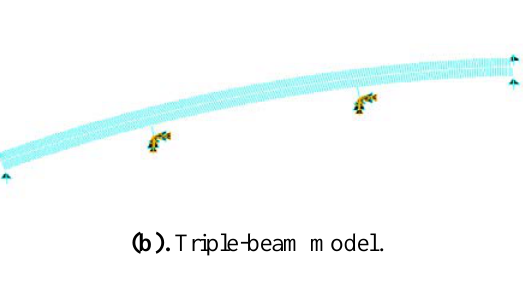
(b). Triple-beam model. Fig. 3. Manchuria Bridge.